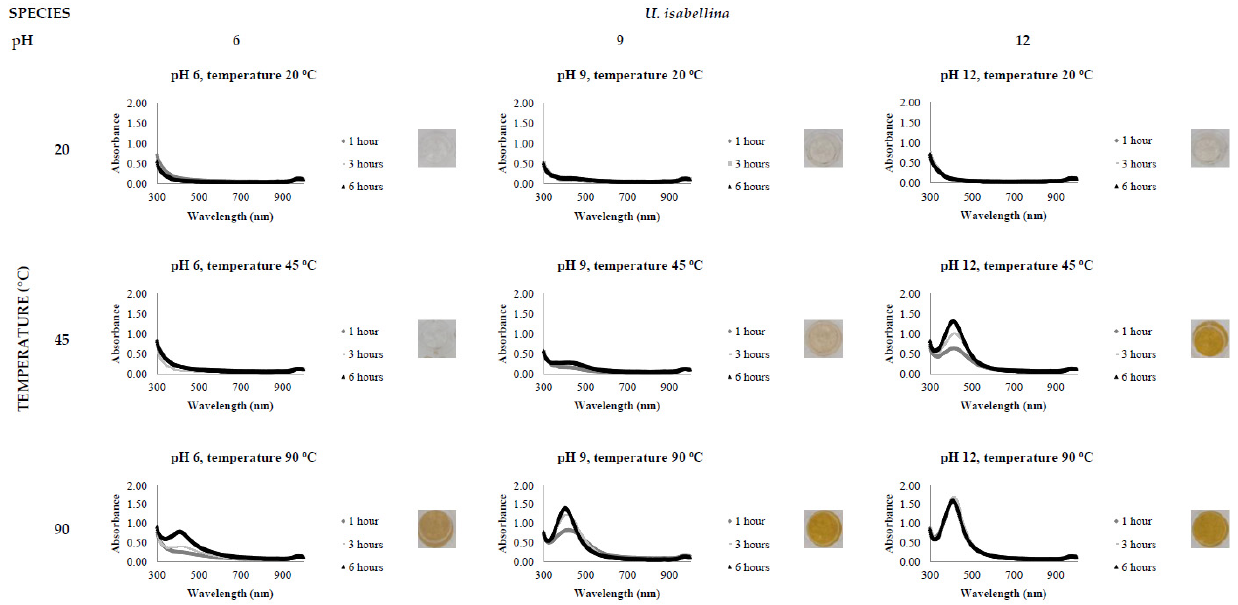
Figure 6. LSPR spectra of U. isabellina cell-free extract in the synthesis of AgNPs, by the addition of 0.5 mM AgNO 3 , varying the reaction time (1, 3 and 6 h), temperature (20, 45 and 90 °C) and pH (6, 9 and 12), through UV-Vis spectrophotometry analysis.